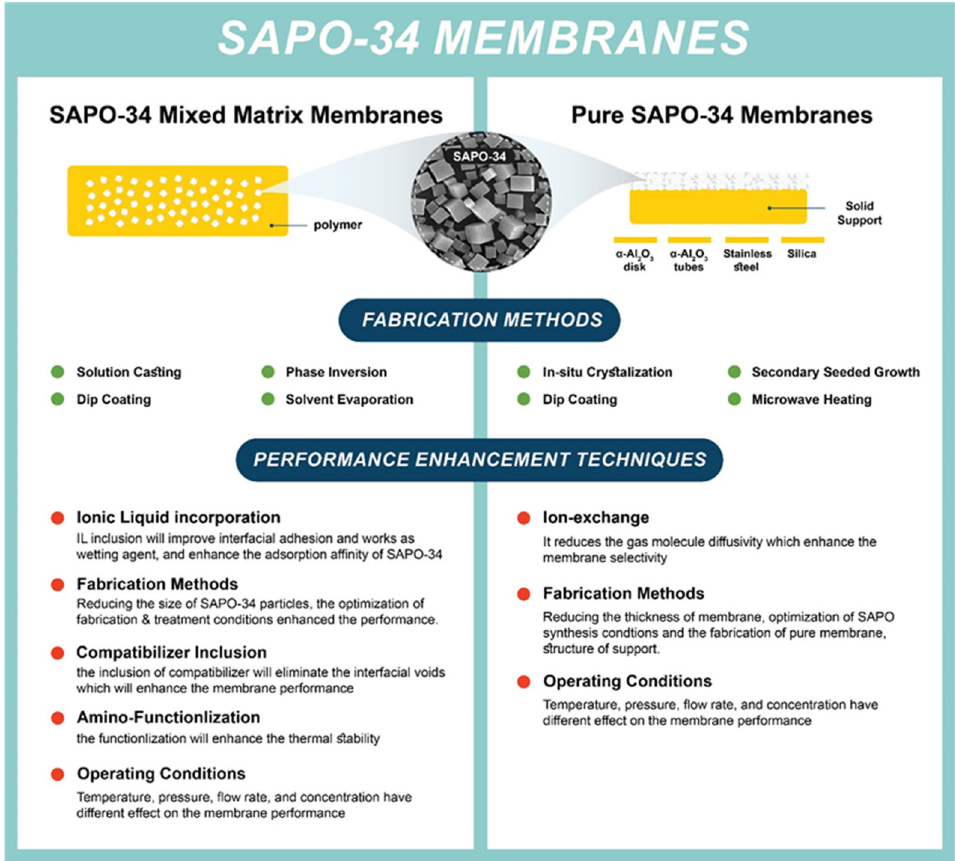
Figure 3. Schematic of fabrication method and performance advancement approaches for SAPO ‐ 34 membranes.